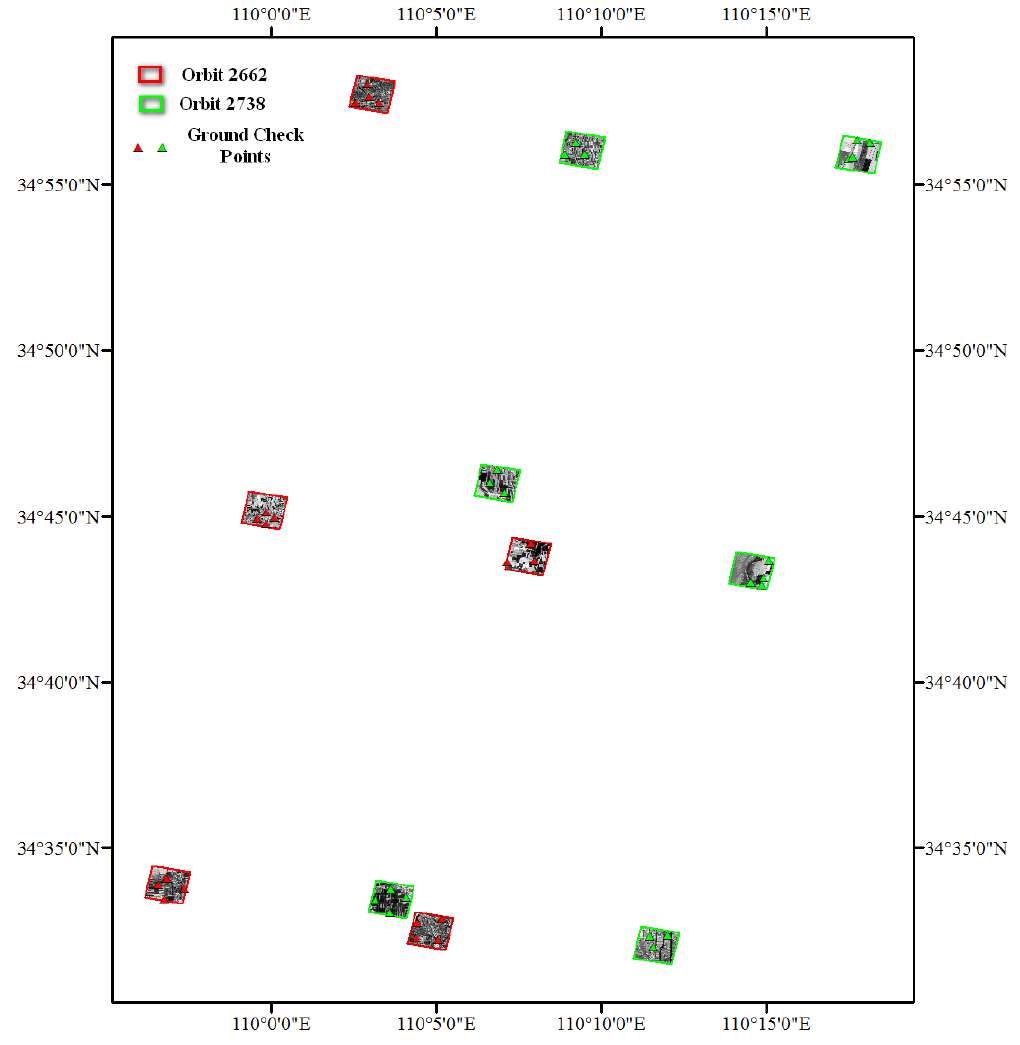
Figure 8. Distribution of checkpoints and laser footprint images in validation area.